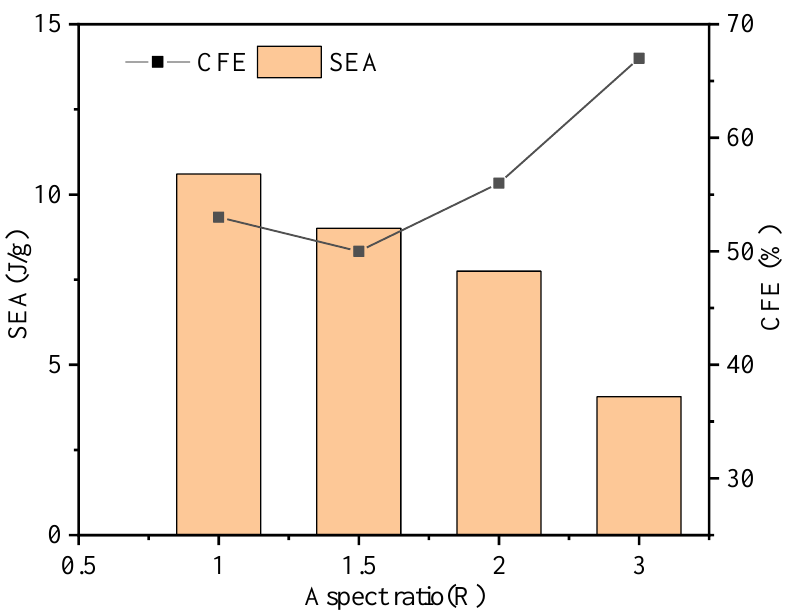
Figure 15. The crashworthiness indicators of the AHSTs with different aspect ratios R .